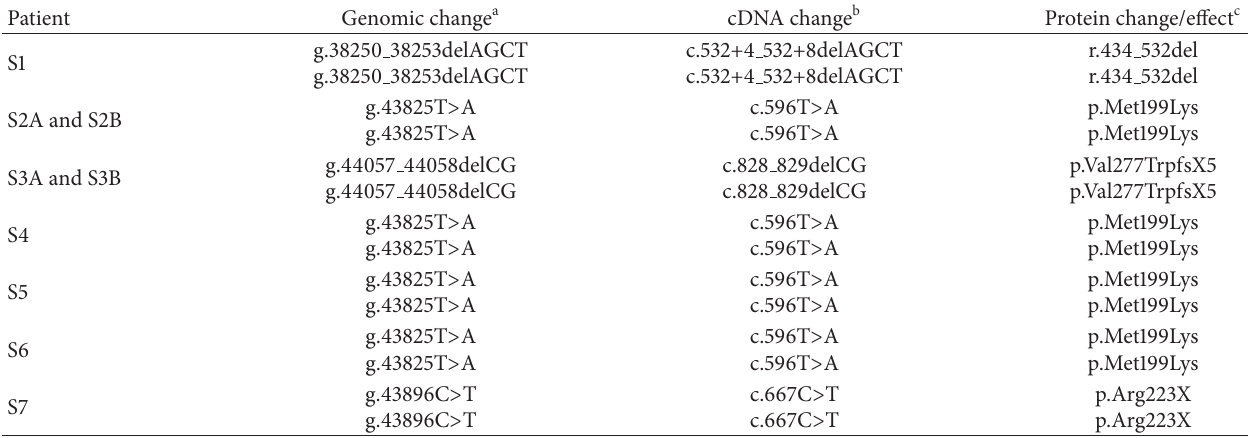
Table 1: Molecular findings in RANKL-dependent ARO